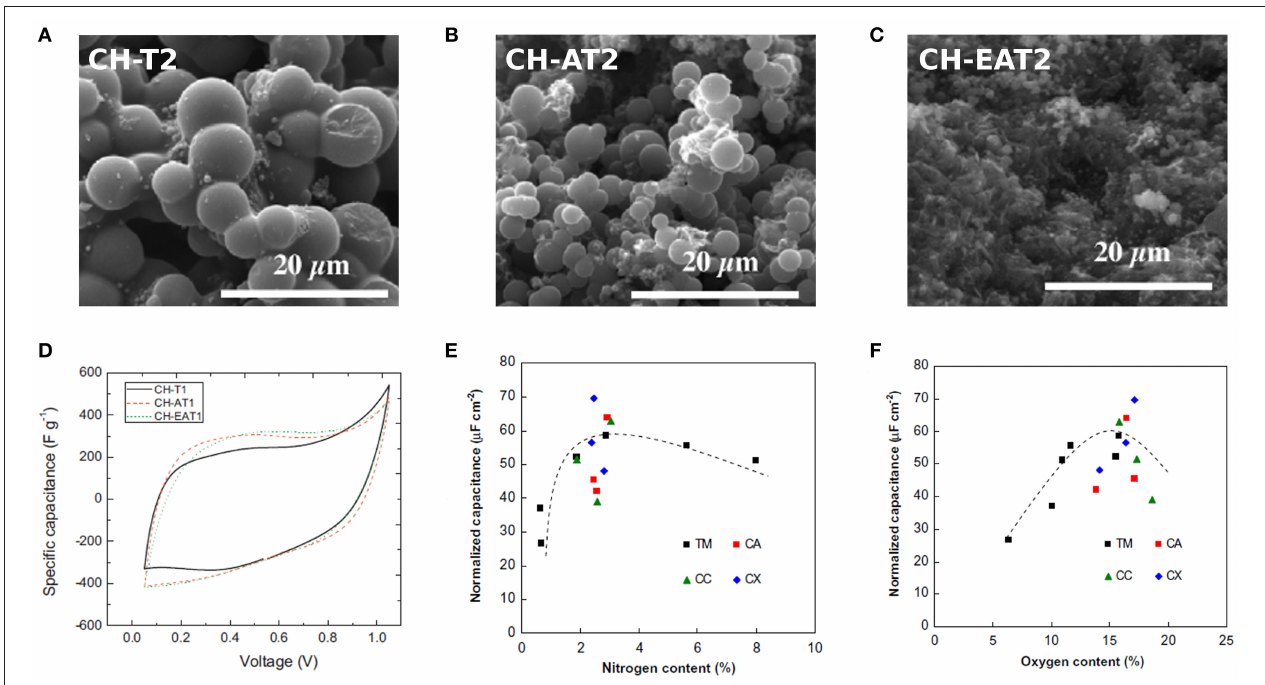
FIGURE 10 | SEM images of materials obtained after HTC at 210 ◦ C and subsequent pyrolysis at 900 ◦ C of tannin in: (A) water, or (B) ammonia solution, and (C) evaporated aminated tannin in water. (D) Examples of cyclic voltammetry curves obtained at 2mV s − 1 from carbonized (900 ◦ C) HTC materials produced at 180 ◦ C (Adapted with permission of Elsevier, from Braghiroli et al., 2015b; permission conveyed through Copyright Clearance Center, Inc.). Normalized capacitance as a function of (E) nitrogen and (F) oxygen content of: carbonized HTC materials produced at 180 and 210 ◦ C, referred to as TM, and of EAT-derived CGs, referred to as CA, CC, and CX for carbon aerogels, cryogels and xerogels, respectively (Adapted with permission of Elsevier, from Braghiroli et al., 2015c; permission conveyed through Copyright Clearance Center, Inc.). The sample labels correspond to those used in their respective source